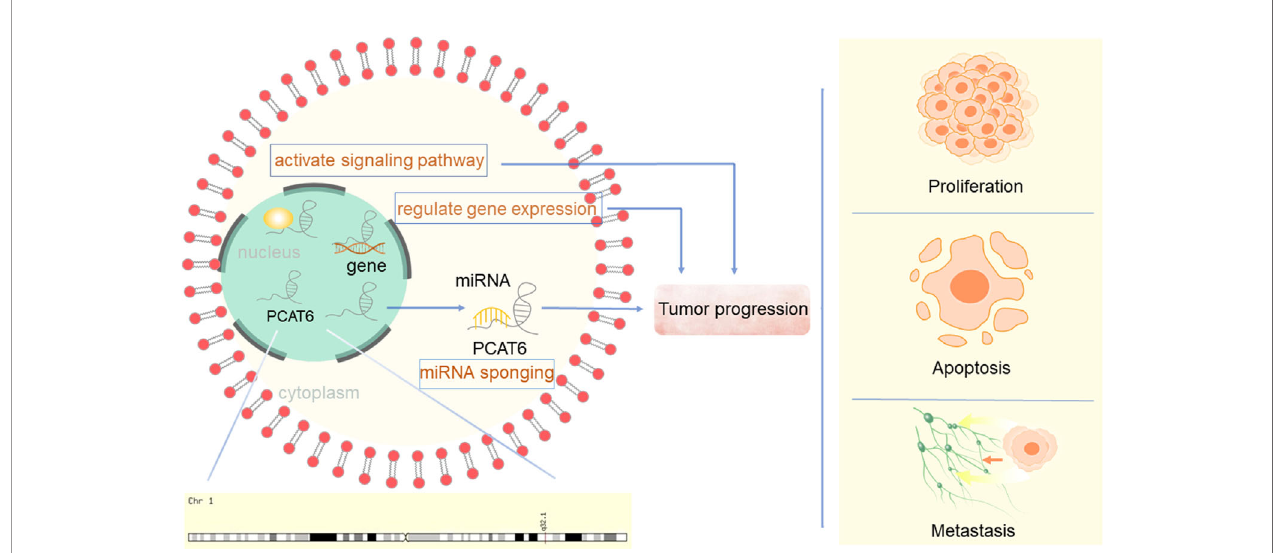
FIGURE 1 | LncRNA PCAT6 promote cancer progression through different